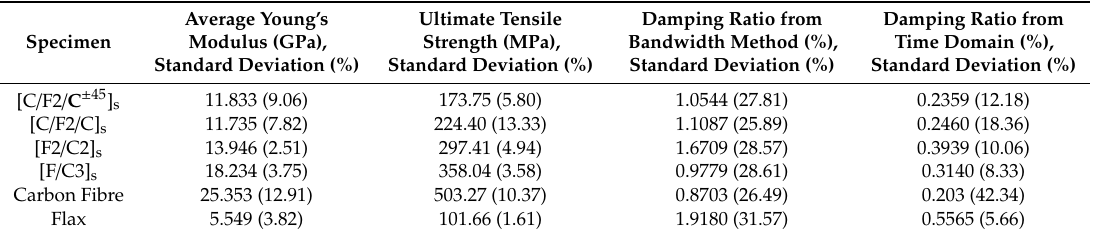
Table 2. Tensile test results on Young’s modulus vs flax fibre content and the damping ratios calculated from frequency and time